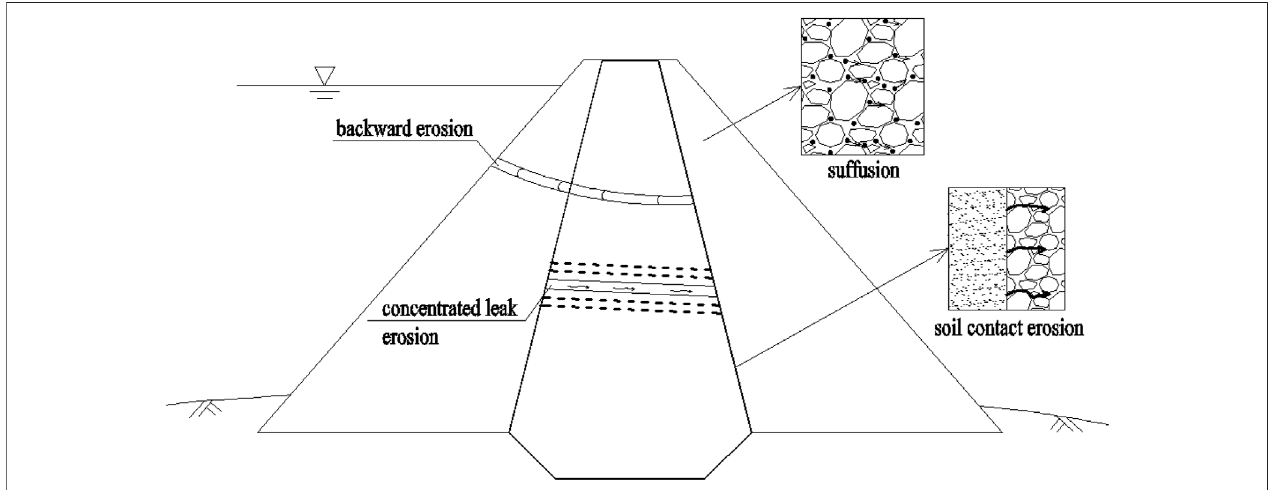
FIGURE 1 | Diagram of internal erosion in a dam slope: concentrated leak erosion, backward erosion, soil contact erosion, and suffusion (Fell and Fry, 2007).